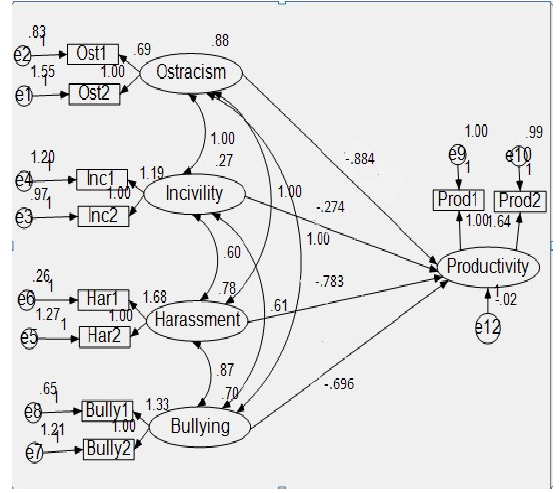
Figure 1. Path Analysis ‐ I.